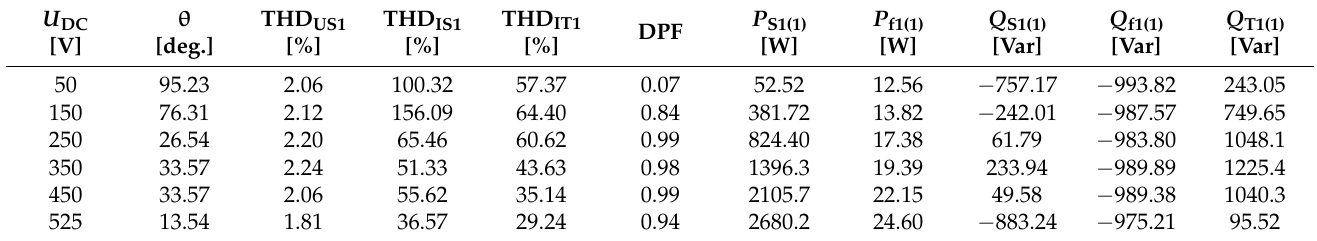
Table 6. Power system parameters measured in the laboratory for different rectifier firing angles